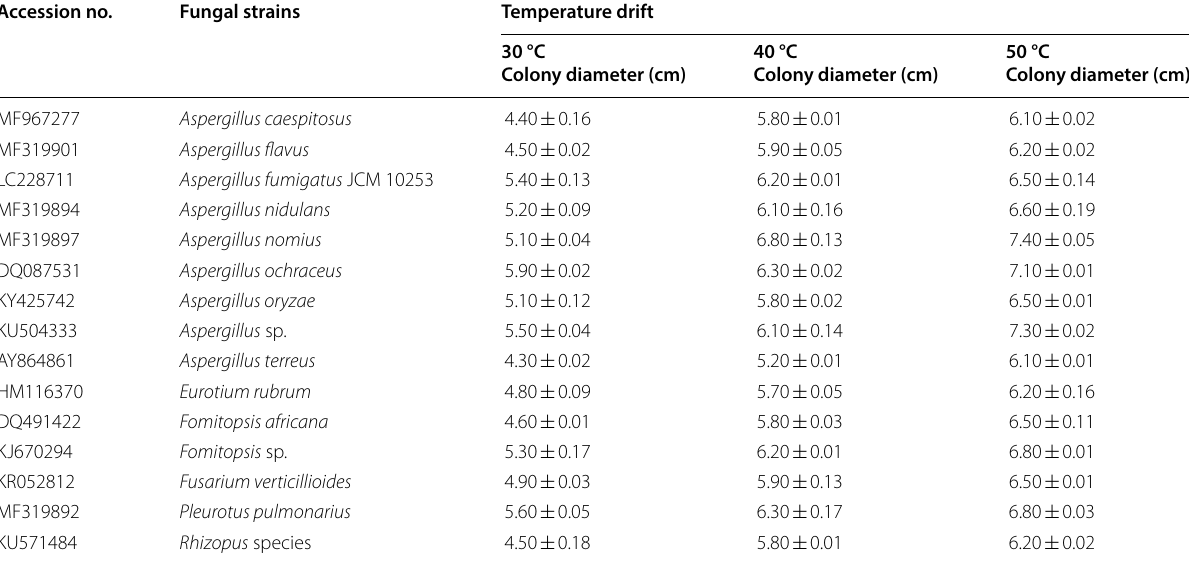
Table 1 List of the selected fungal strains isolated from soil source and its observation after temperature drift Accession